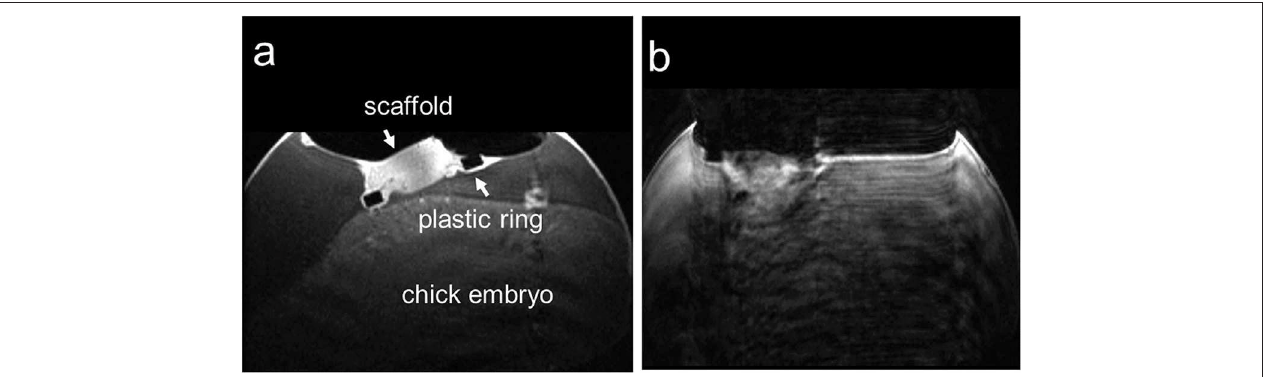
FIGURE 4 | Two in ovo T1-weighted MR images of the chick embryo on ID 14, seven days post-implantation on the CAM acquired in an axial slice through the biomaterial scaffold; (a) image without motion artifact and (b) image with motion artifacts that was excluded from further analysis. This research was